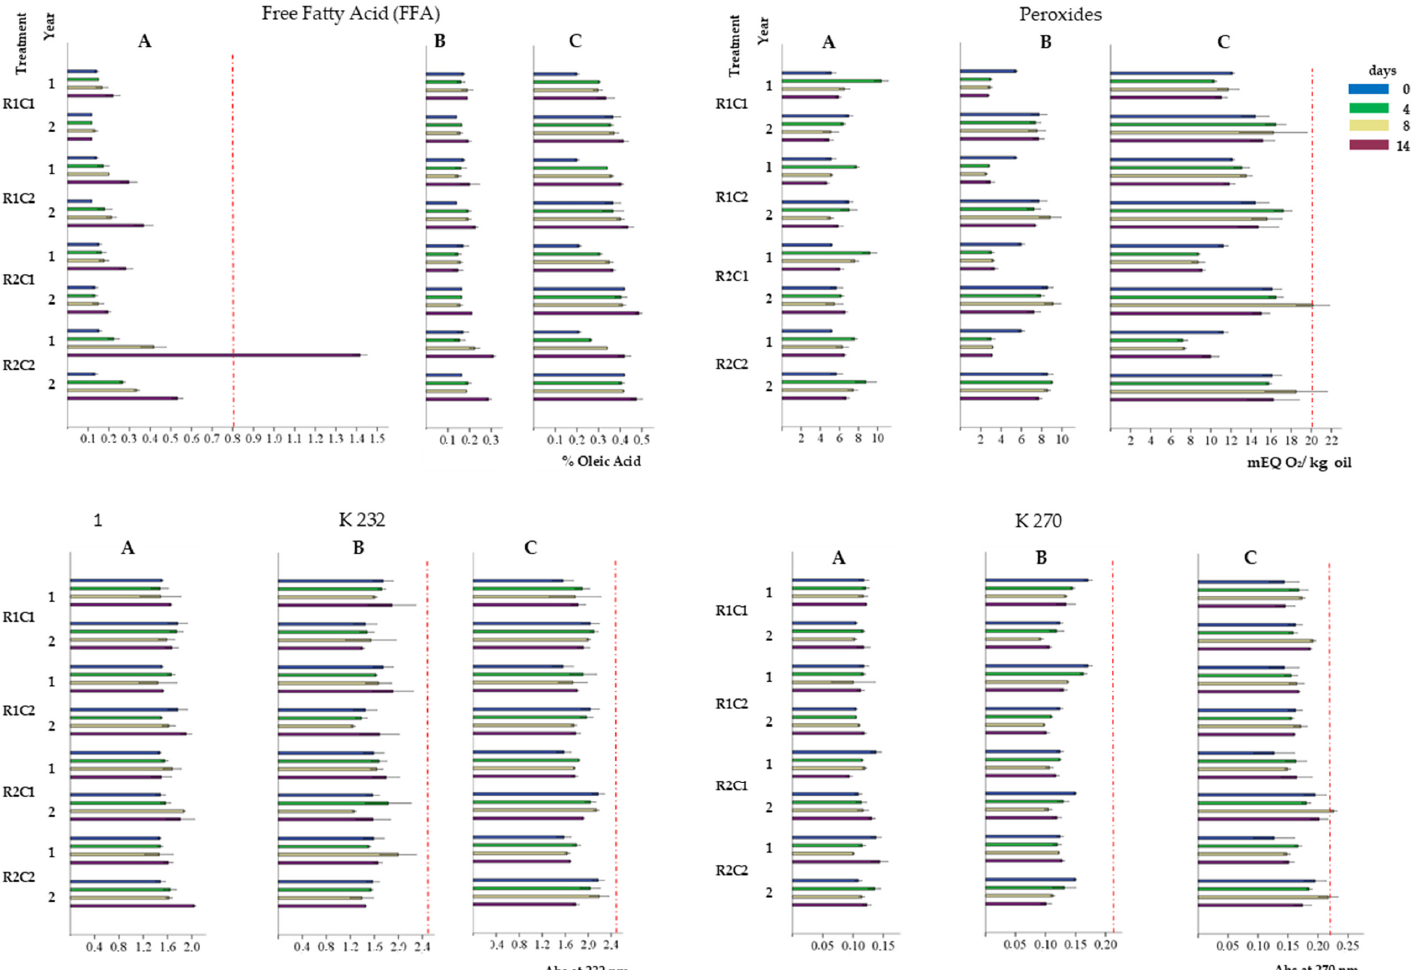
Figure 1. Free fatty acid (% oleic acid), peroxides (mEq O2/ kg oil), and absorbency at 232 and 270 nm, noted in the ‘Arbequina’ ( A ), ‘Picual’ ( B ), and ‘Verdial’ ( C ) olive oils extracted from fruit, picked with a Manual Inverted Umbrella (R1) and in a traditional way (R2) and stored for different days at 5 °C (C1) and ambient temperature (C2) during two consecutive years. Each bar is the mean ± SD of 3 replicates. Dotted lines indicate EVOO min. values (EEC).